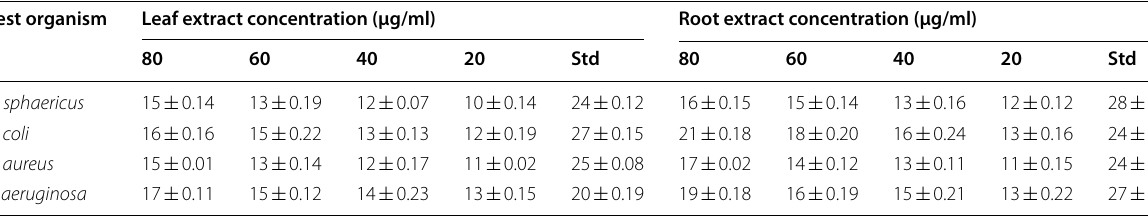
Table 3 Antibacterial activity of Solanum khasianum extracts on tested bacteria Test organism Leaf extract concentration (µg/ml) Root extract concentration